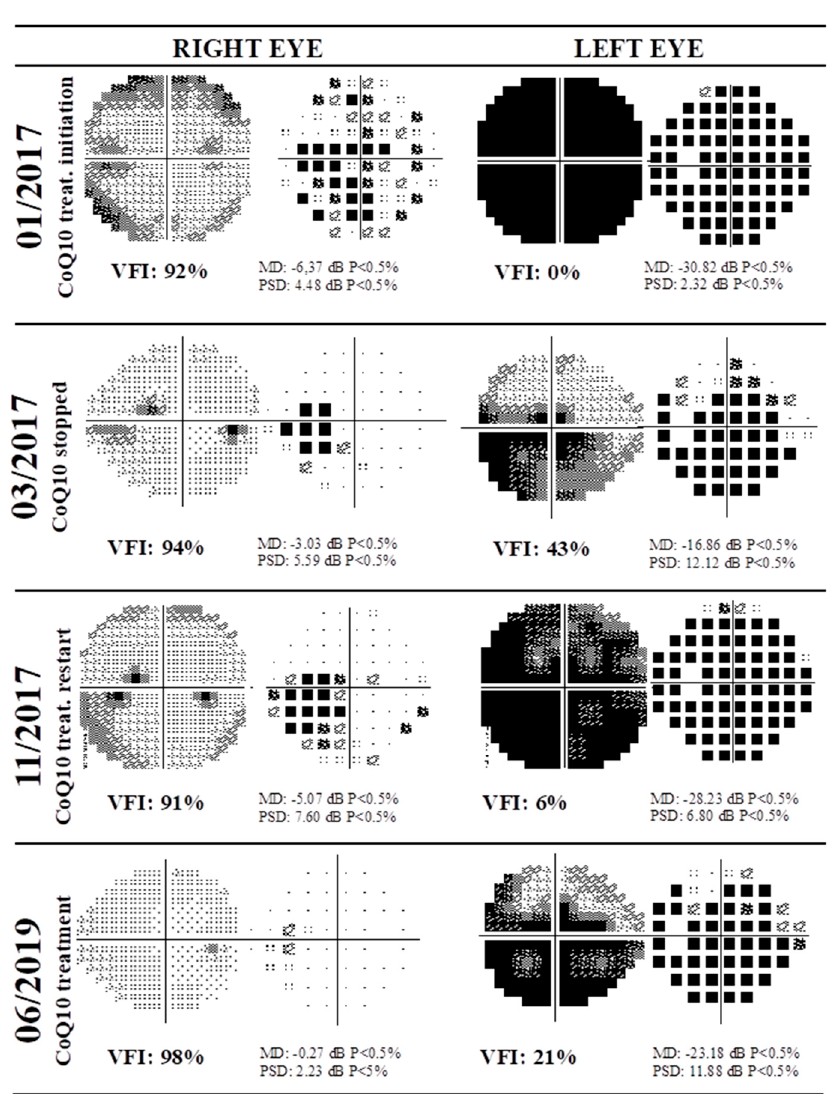
Figure 4. Visual field test using Humphrey field analyzer and 30-2 algorithm of a patient diagnosed with NAION (NAION02) from 2017 to 2019. Rows represent visual fields of each eye. In January 2017 the patient presented NAION in left eye, and received CoQ10 treatment. In March 2017 the CoQ10 treatment was interrupted, with deterioration in the visual field in November 2017; treatment was restarted, with observed improvement in the visual field index in June 2019.